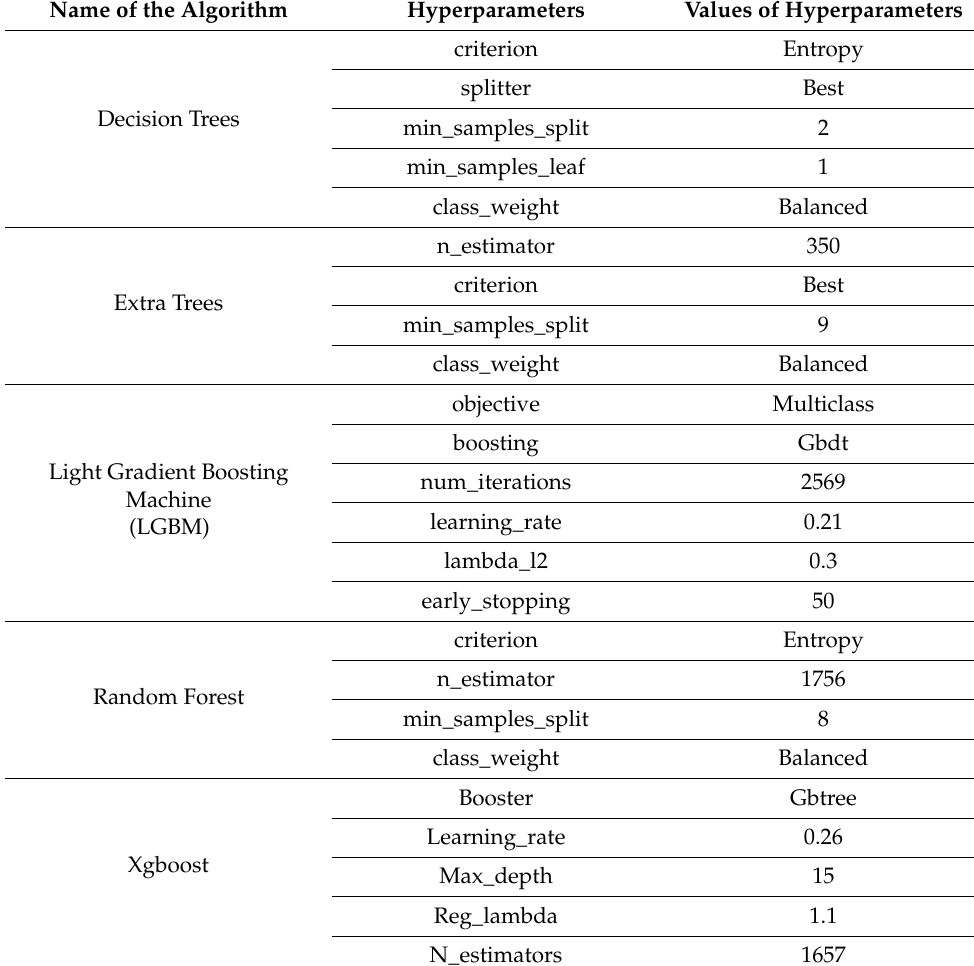
Table 5. Values of hyperparameters of different machine learning